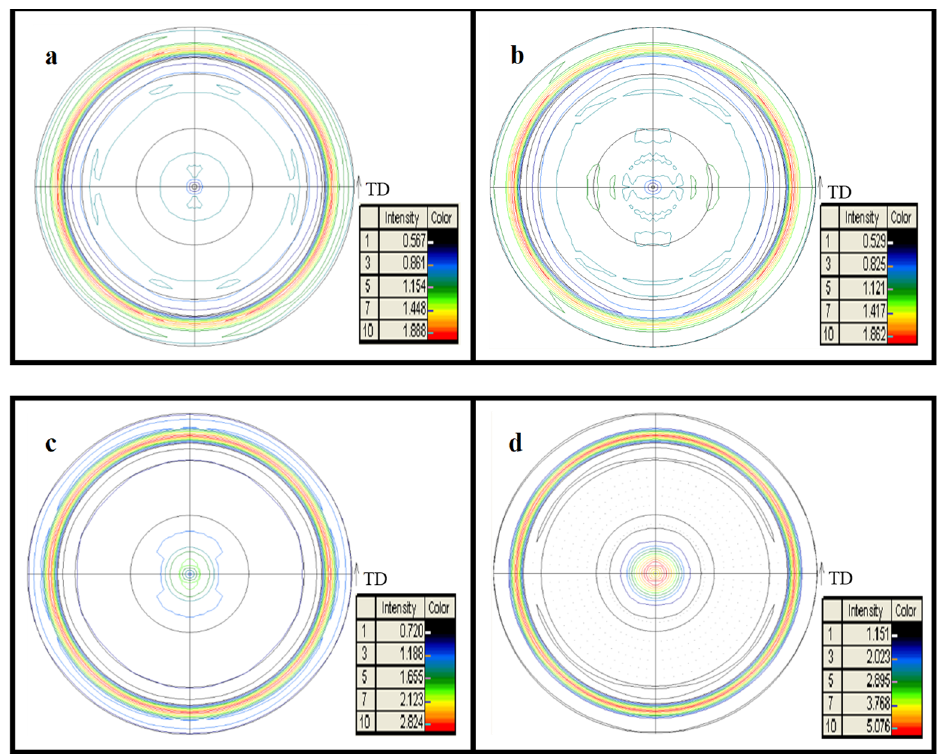
Figure 2. Pole figures of HfC coatings deposited at different bias voltages: ( a ) 0 V, ( b ) − 100 V, ( c ) − 150 V, and ( d ) − 200 V.